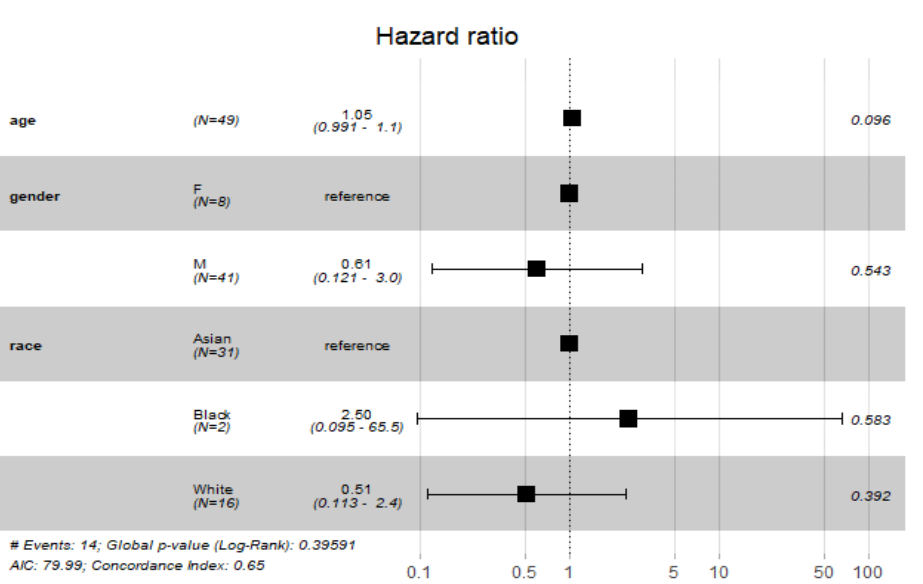
COVID-19 patients (Figure 2). Figure 1. Body temperature before and after Tocilizumab.